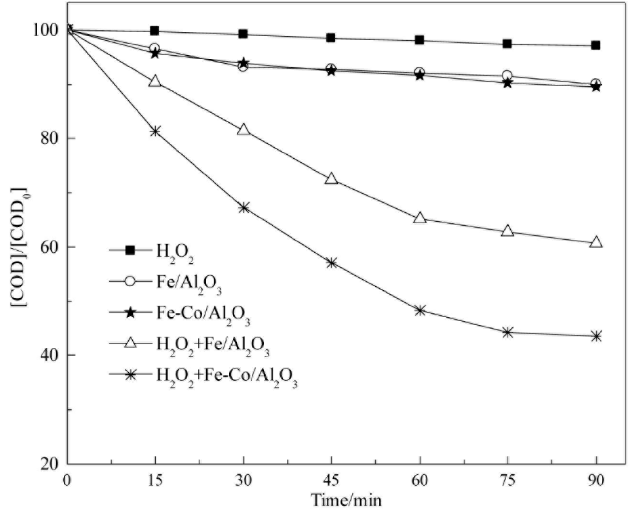
Table 3. Catalyst component.